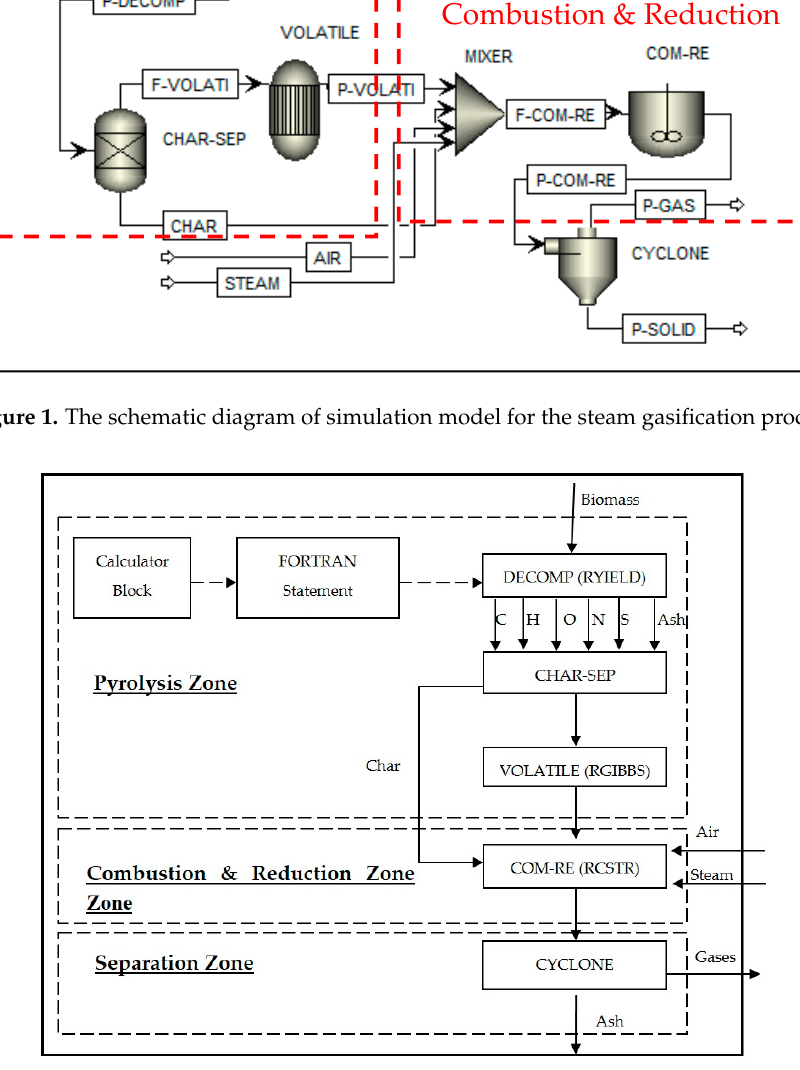
Figure 2. Simulation procedure of the steam gasification process.